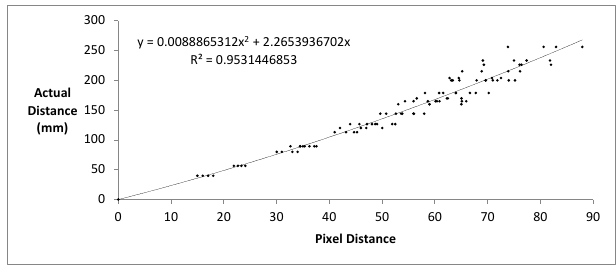
Figure 16: Results of lens distortion analysis Figure 17. Results of lens distortion analysis.